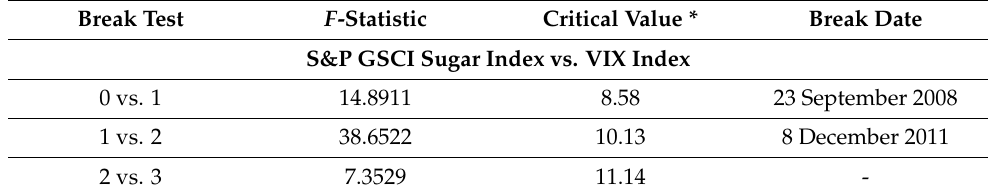
Table 2. Bai–Perron sequential test results for the S&P GSCI Sugar Index and the VIX Index. Break Test F -Statistic Critical Value